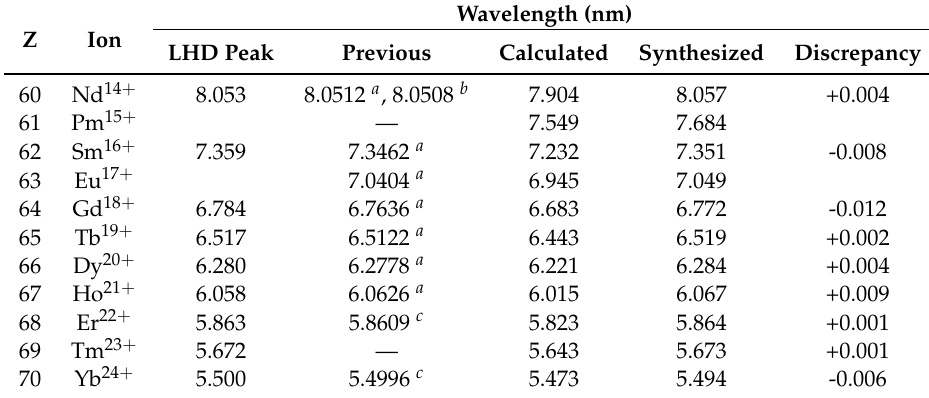
Table 3. Comparisons of the reported wavelengths of the 4d 10 1 S 0 –4d 9 4f 1 P 1 transitions of Pd-like ions with the nearest peak measured in the LHD. The wavelengths calculated by GRASP92 and RATIP are listed, as well. The uncertainty of the wavelengths measured in the LHD is estimated to be less than ± 0.004 nm. The synthesized wavelengths are also listed (see the text for details). The discrepancies of the synthesized values from the LHD values are listed in the last column. References: a [42], b [43], c